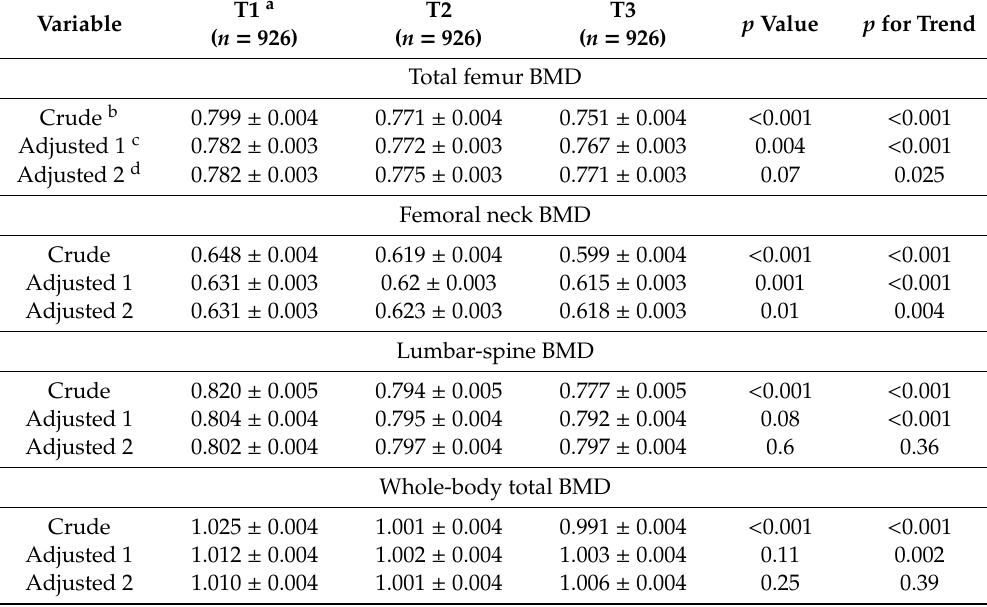
Table 2. Bone-mineral density (BMD) by DII ® Score.